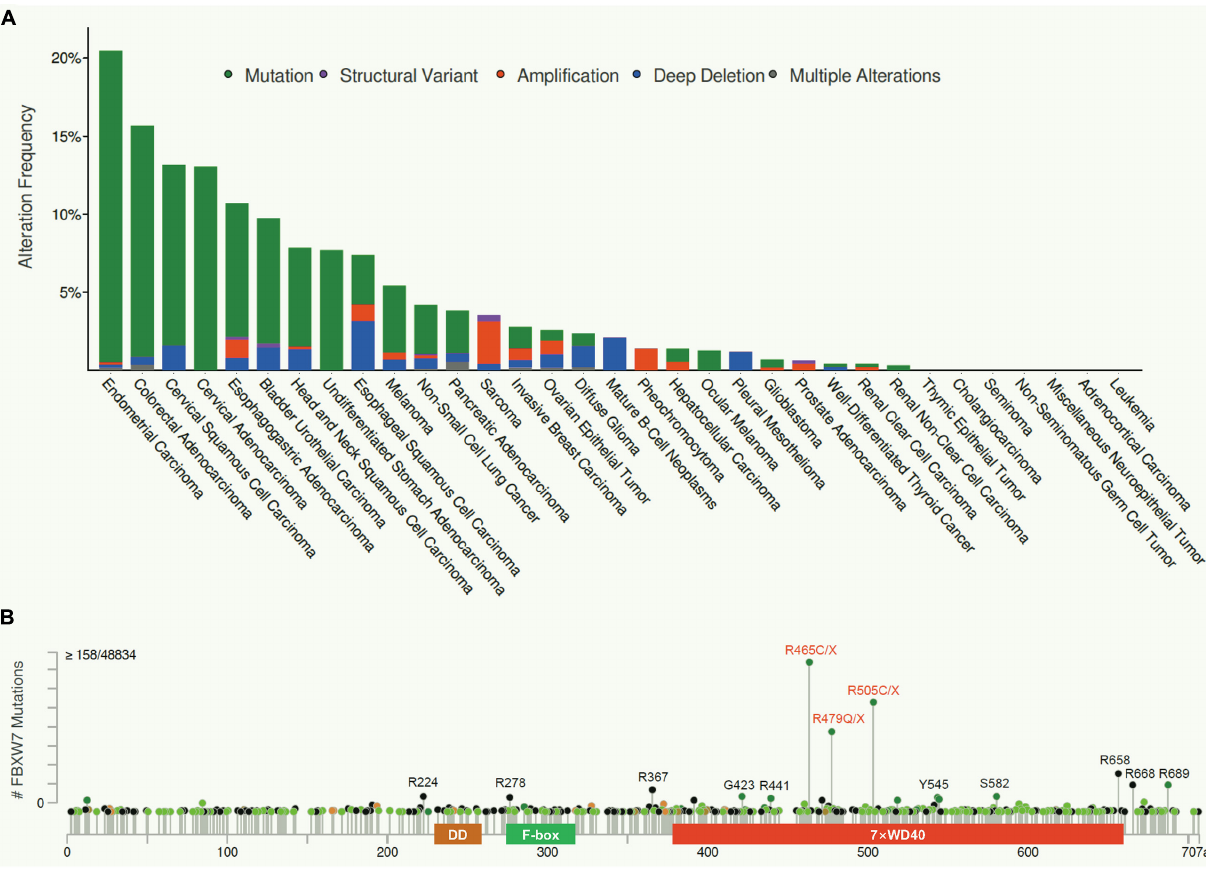
Table 1 . Almost all substrates contain a evolutionarily